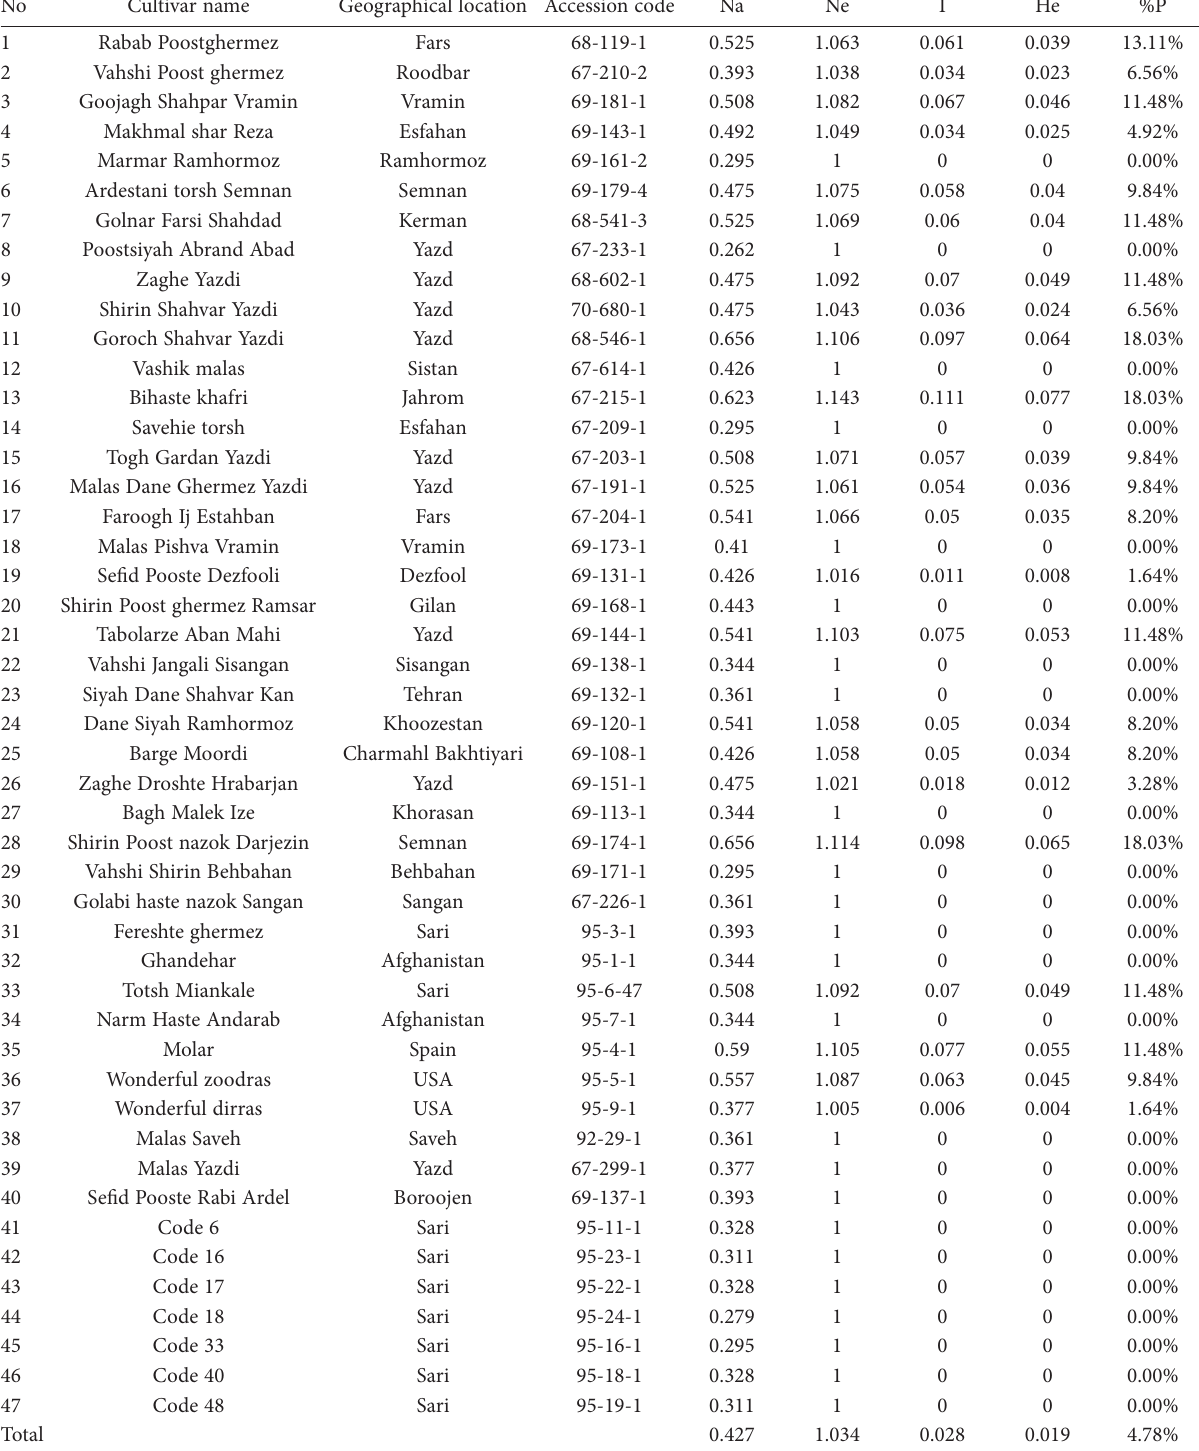
Table 1. Genetic diversity parameters determined in Punica genotypes